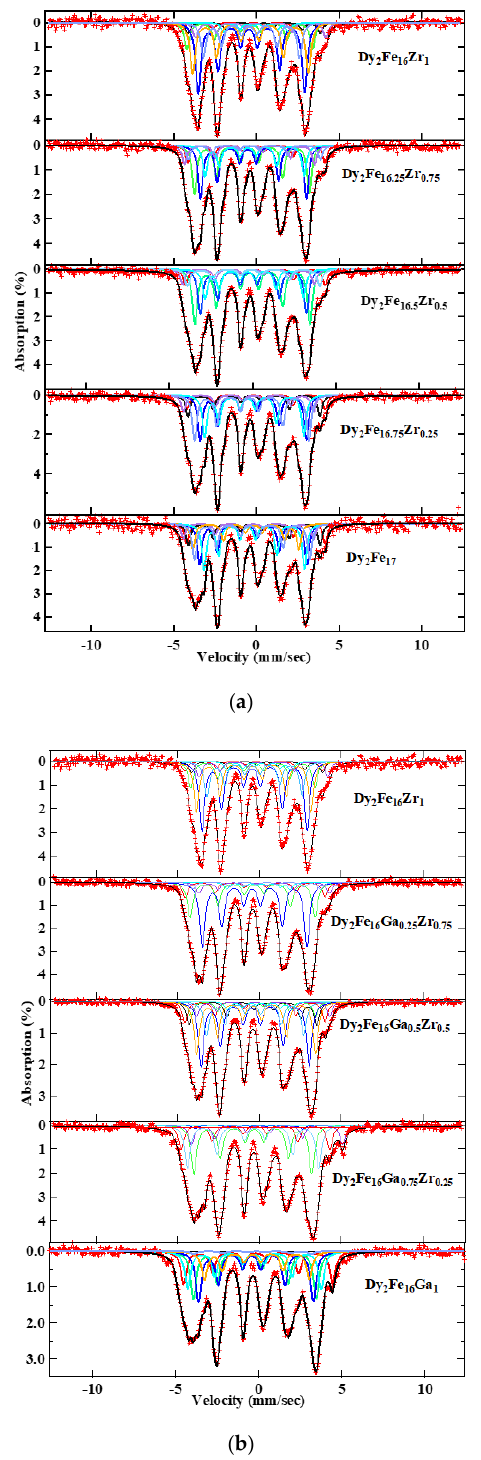
Figure 7. RT Mössbauer spectra for ( a ) Dy 2 Fe 17 − x Zr x , and ( b ) Dy 2 Fe 16 Ga 1 − x Zr x.